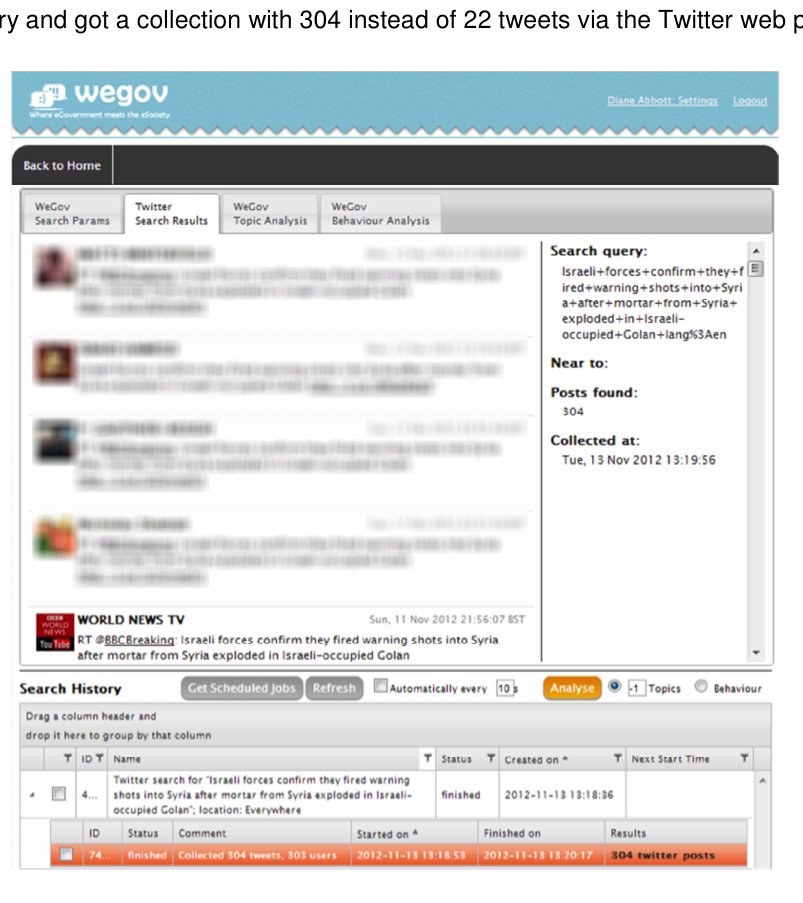
Figure 9: Twitter Search via WeGov